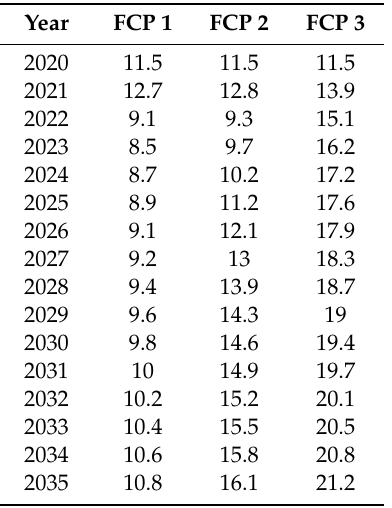
Table A1. FCR payment within the proposed future scenarios (EUR / MW /